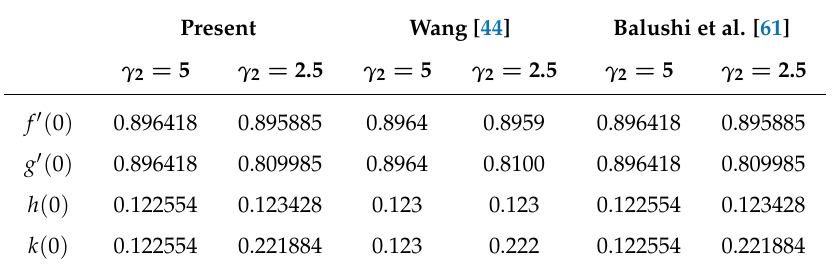
Table 1. A comparison data with previous published results for λ = 1, γ 1 = 5 and various γ 2 . Present Wang